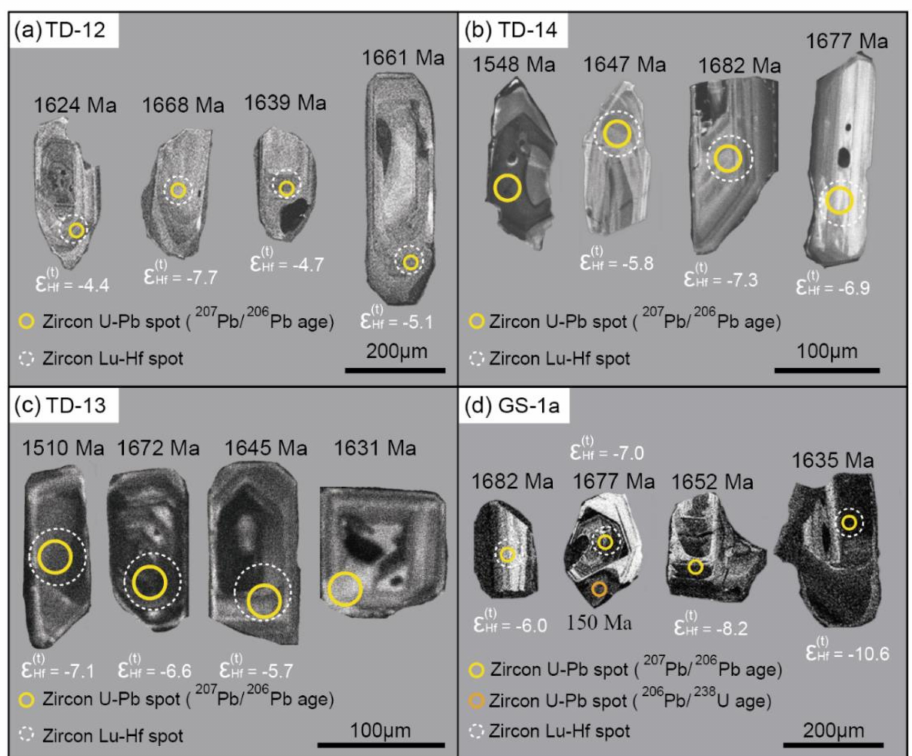
Figure 6. Zircon CL images of the AFG ( a , b ) and PAFG ( c , d ) with analyzed